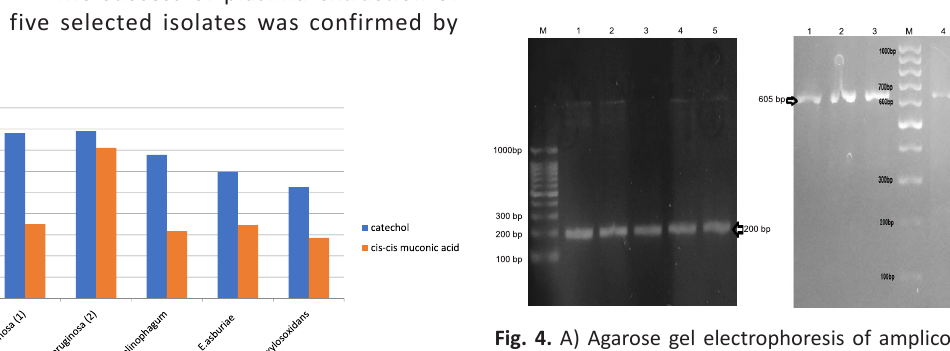
Fig. 4. A) Agarose gel electrophoresis of amplicon of specific sequence of cat2,3 gene (200 bp) in all isolates . B) Agarose gel electrophoresis of amplicon of specific sequence of cat1,2 gene (605 bp) in all